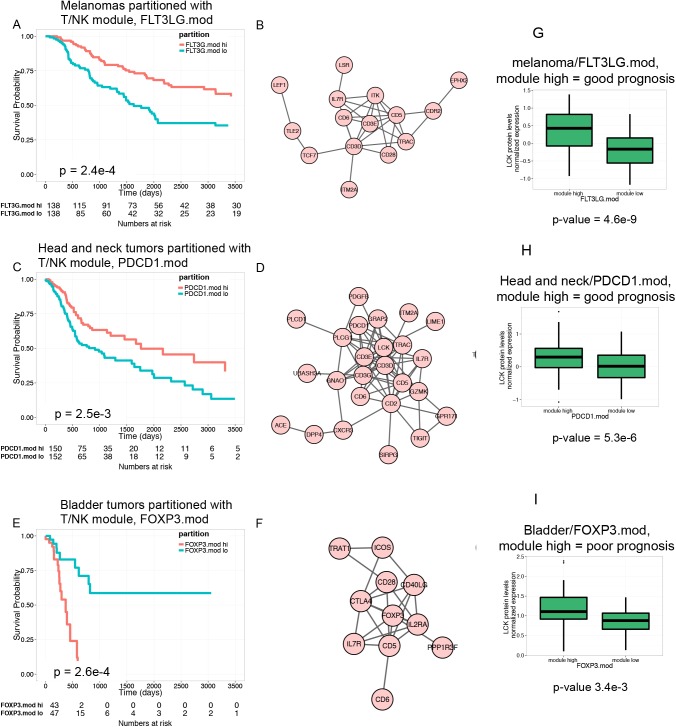
Expression of T/NK module genes may be oppositely associated with patient survival.A) Overexpression of FLT3LG.mod genes is positively associated with survival of melanoma patients. Shown is a KM plot depicting survival of melanoma patients stratified by expression of FL3LG.mod. FLT3LG mod hi, tumors having greater than median expression of module genes; FLT3LG.mod lo, tumors having less than or equal to than median expression of module. B). Network graph of FLT3LG.mod genes from a protein-protein interaction network shows interconnected T cell genes. C) Overexpression of PDCD1.mod genes is positively associated with survival of head and neck tumor patients. Shown is a KM plot depicting survival of head and neck tumor patients stratified by expression of PDCD1.mod. D). Network graph of PDCD1.mod genes shows interconnected T cell genes. E) Overexpression of FOXP3.mod genes is negatively associated with survival of bladder tumor patients. Shown is a KM plot depicting survival of bladder tumor patients stratified by expression of FOXP3.mod. F) Network graph of FOXP3.mod genes shows interconnected T cell genes, including Treg genes FOXP3, IL2RA and CTLA4. G-I) Tumors partitioned by levels of T/NK cell transcripts also show differences in levels of T cell protein, LCK. LCK expression was measured by RPPA. G) LCK protein levels in FLT3LG.mod hi versus FLT3LG.mod lo melanomas. H) LCK protein levels in PDCD1.mod hi versus PDCD1.mod lo head and neck tumors. I) LCK protein levels in FOXP3.mod hi versus FOXP3.mod lo bladder tumors.